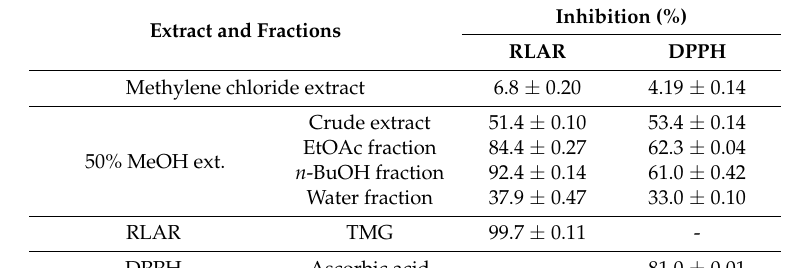
Table 1. Inhibitory effect of 50% MeOH extract of Agrimonia pilosa Ledeb. on rat lens aldose reductase (RLAR) and 1,1-diphenyl-2-picrylhydrazyl (DPPH) free radical scavenging activity. TMG: tetramethylene glutaric acid.